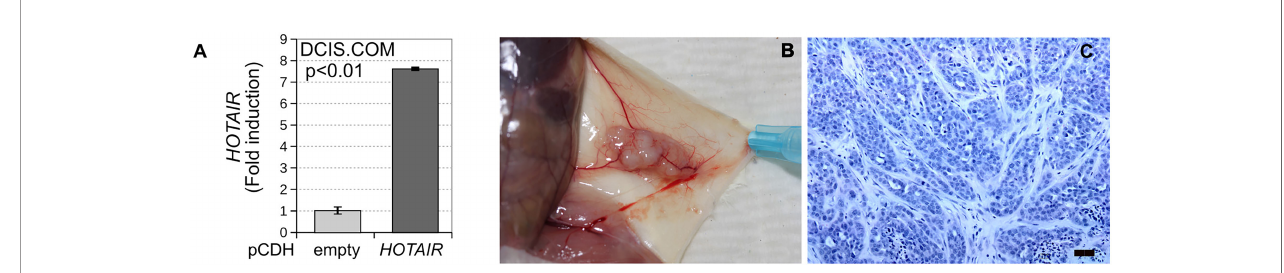
FIGURE 4 | DCIS.COM stably transduced cells with either vector control or lentivirus expressing HOTAIR were compared using the in vivo MIND model. (A) HOTAIR expression levels in stably transduced DCIS.COM cells based on their RNA-seq pro fi les (log2 CPM). (B) DCIS growth was detected among injected mice. (C) Representative invasive ductal carcinoma (10X H&E staining) induced by DCIS.COM cells stably transduced with HOTAIR . Scale bar: 200